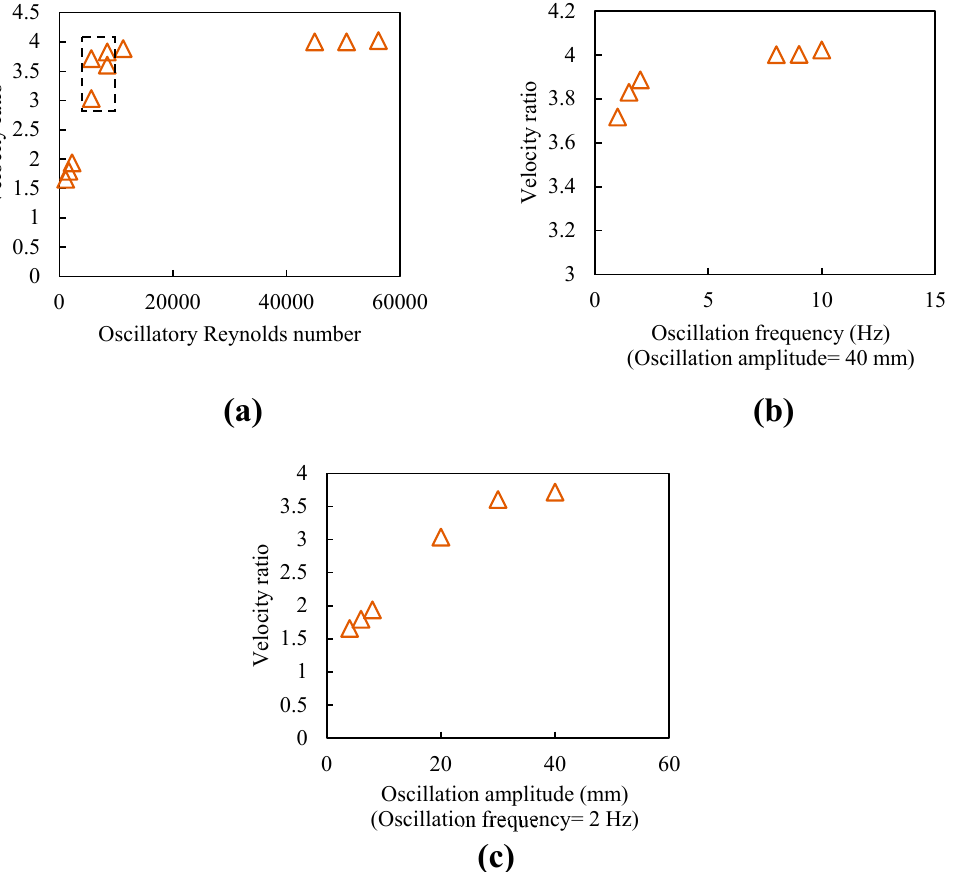
Figure 5. Velocity ratio versus ( a ) oscillatory Reynolds number, ( b ) oscillation frequency, and ( c ) Figure 5 . Velocity ratio versus (a) oscillatory Reynolds number, (b) oscillation frequency, and (c) oscillation oscillation amplitude.